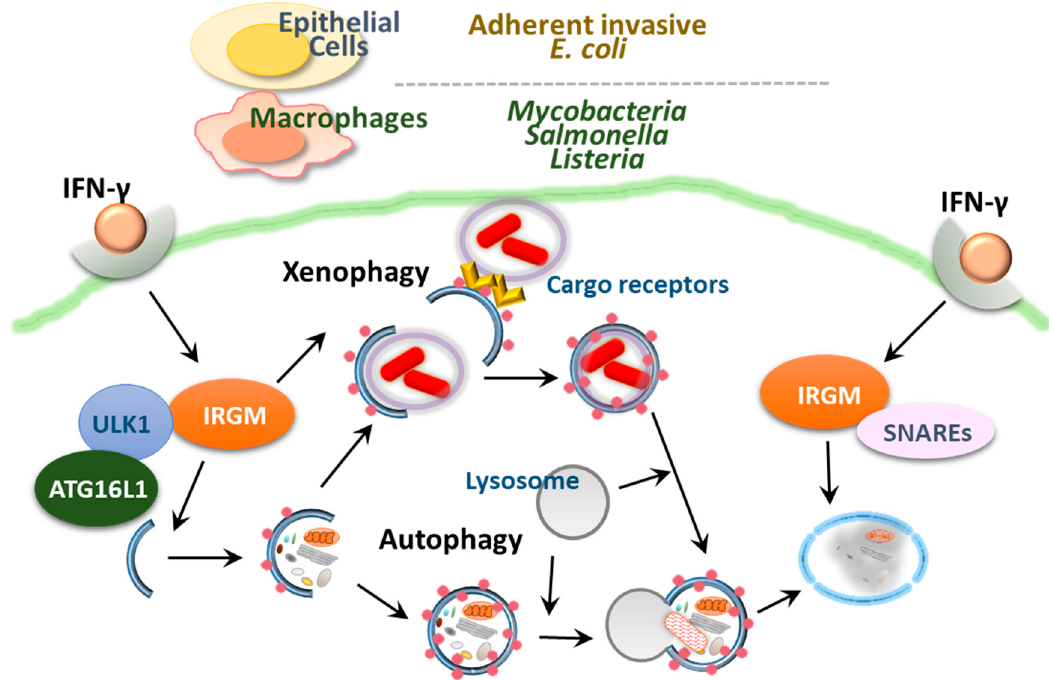
Figure 4. Autophagy targets adherent-invasive Escherichia coli (AIEC), Mycobacteria, Salmonella and Listeria by different mechanisms. Stimulation with IFN- γ induce IRGM to clear intracellular bacteria. Furthermore, IRGM can be induced by IFN- γ contribute to cell-autonomous defense though autophagy activation via the recruitment of both autophagic and SNARE adaptor proteins during infection.